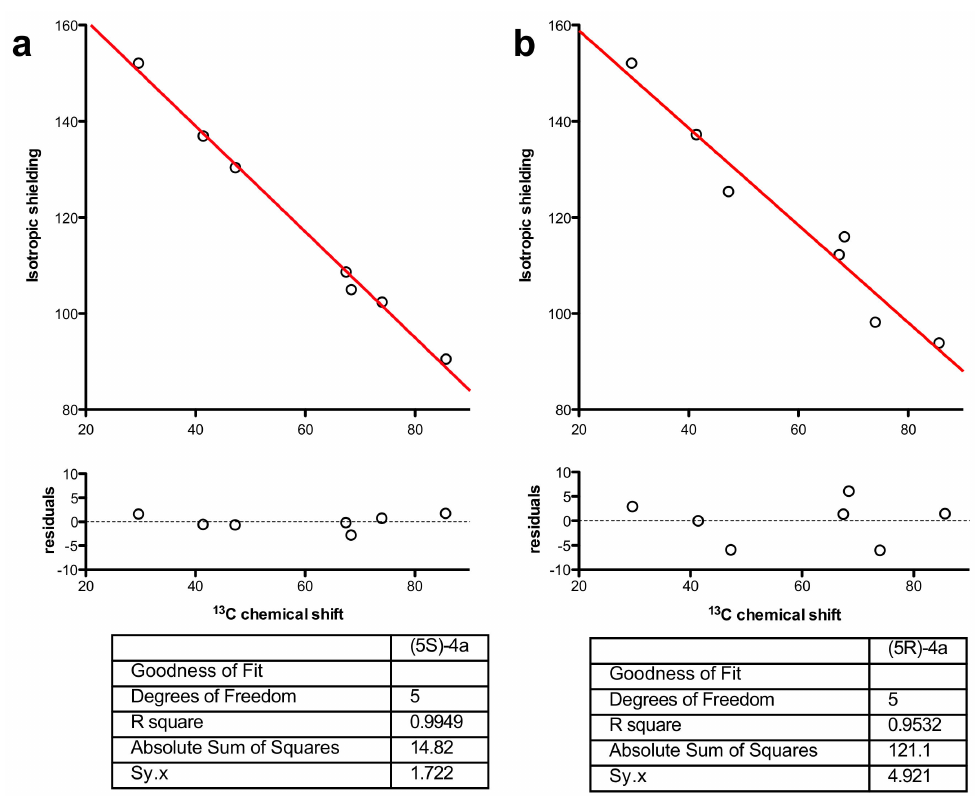
Figure 2. Non-linear regression fitted to a straight line of chemical shifts against calculated isotropic shielding (DFT//B3-LYP/TZVPP) for ( a ) (5 S )-4a and ( b ) (5 R )-4a with residuals and goodness-of-fit